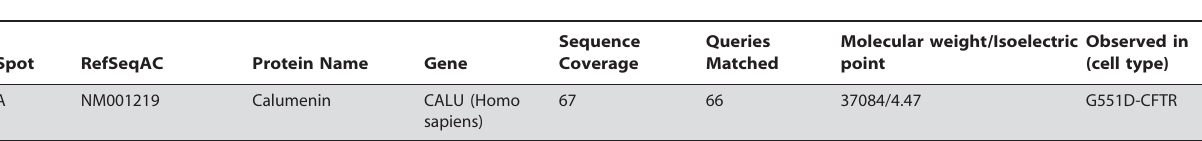
Table 1. Identification of spots A by Mass